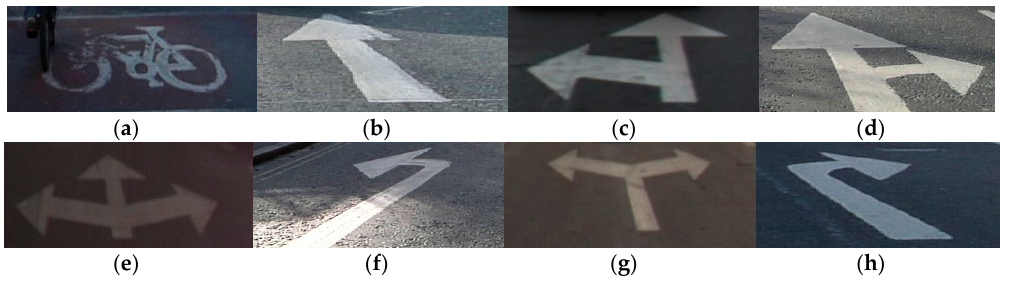
Figure 1. Road marking objects. ( a ) Bike. ( b ) Forward arrow. ( c ) Forward-left arrow. ( d ) Forward-right arrow. ( e ) Forward-left-right arrow. ( f ) Left arrow. ( g ) Left-right arrow. ( h ) Right arrow.